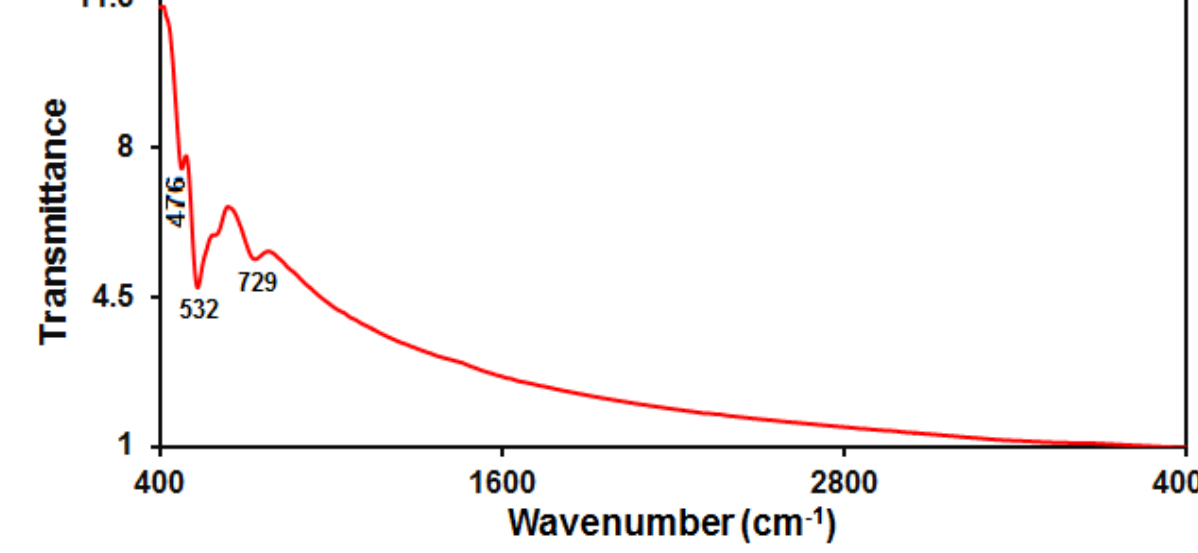
Figure 3. FT-IR pattern captured for as-fabricated manganese dioxide nanorods.